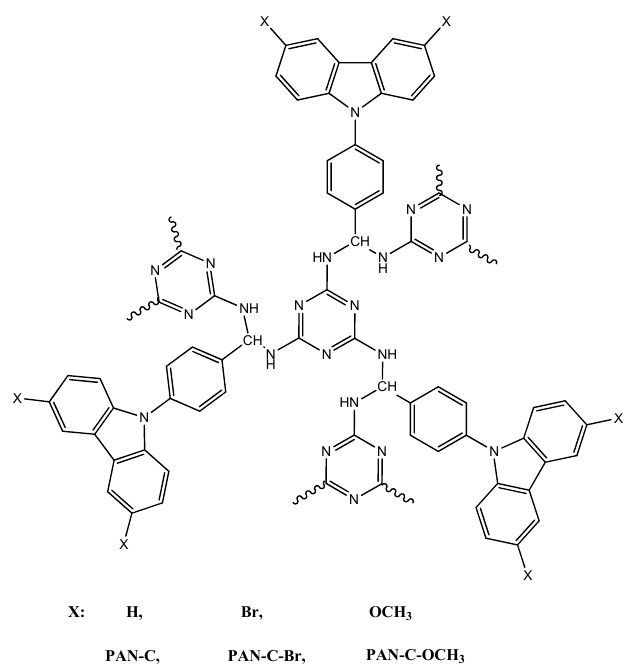
Figure 8. Chemical structure of carbazole-based porous polyaminals (PAN-C, PAN-C–Br, and PAN-C–OCH 3 ).